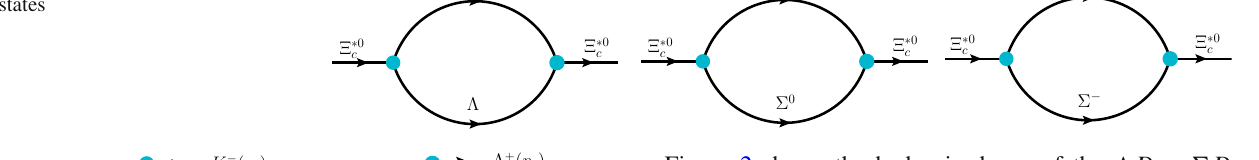
Fig. 1 Self-energy of the (cid:2) ∗ c states